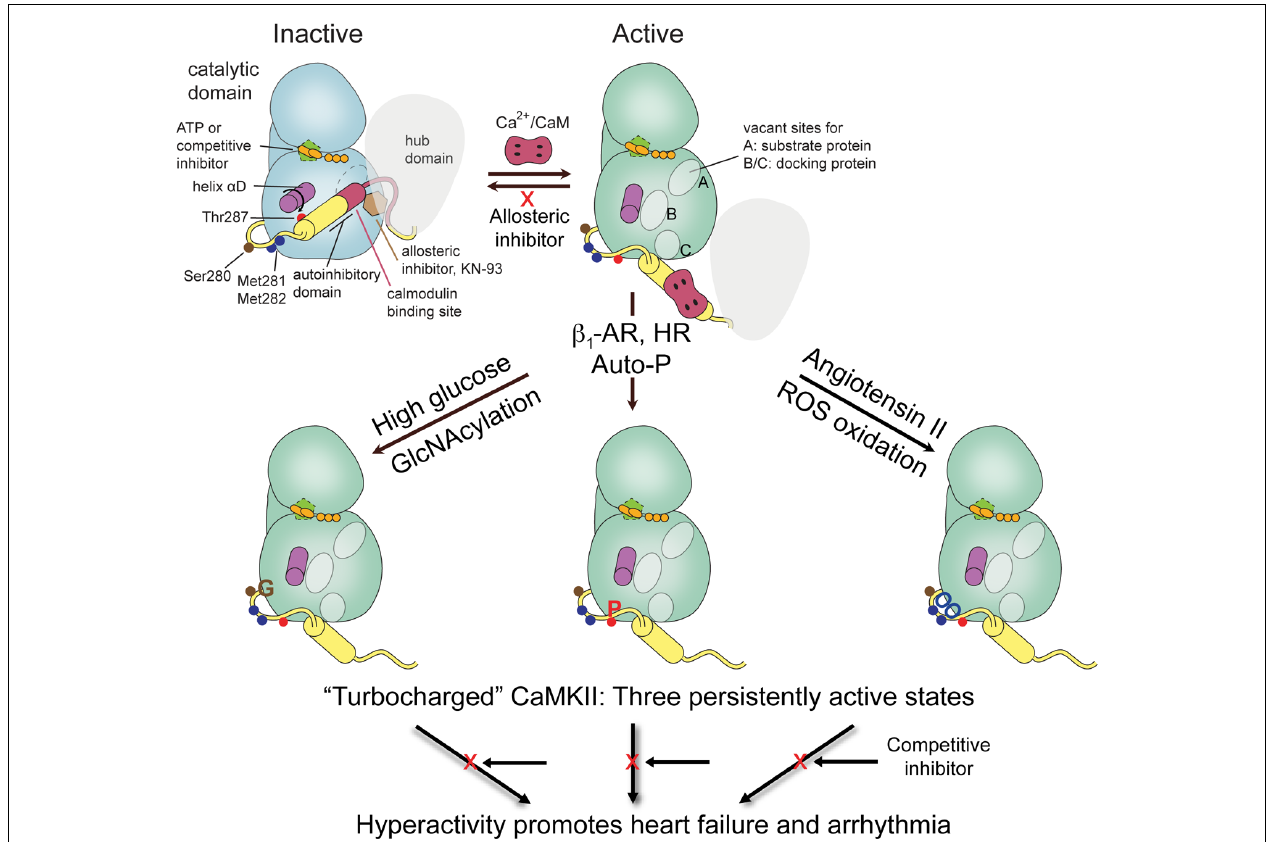
FIGURE 1 | CaMKII domain organization and schematic of activation states. One subunit of a holoenzyme composed of hub and bi-lobed catalytic domain is shown in the inactive conformation.The autoinhibitory domain or regulatory segment contains the PTM segment, important for regulation by phosphorylation, oxidation, and GlcNAcylation, followed by the CaM binding domain. Binding of Ca 2 + /CaM displaces the autoinhibitory domain leading to rearrangement of the lower or C-lobe of the kinase allowing substrate access